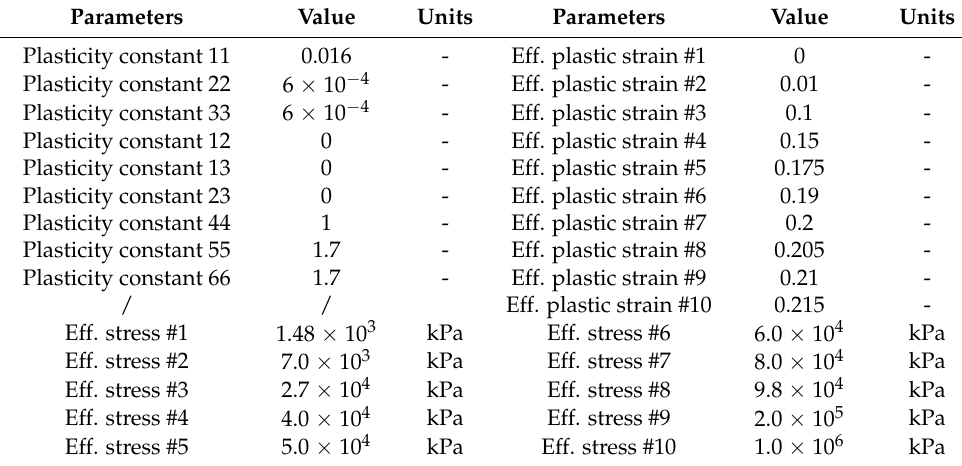
Table 7. Material constants for Orthotropic yield